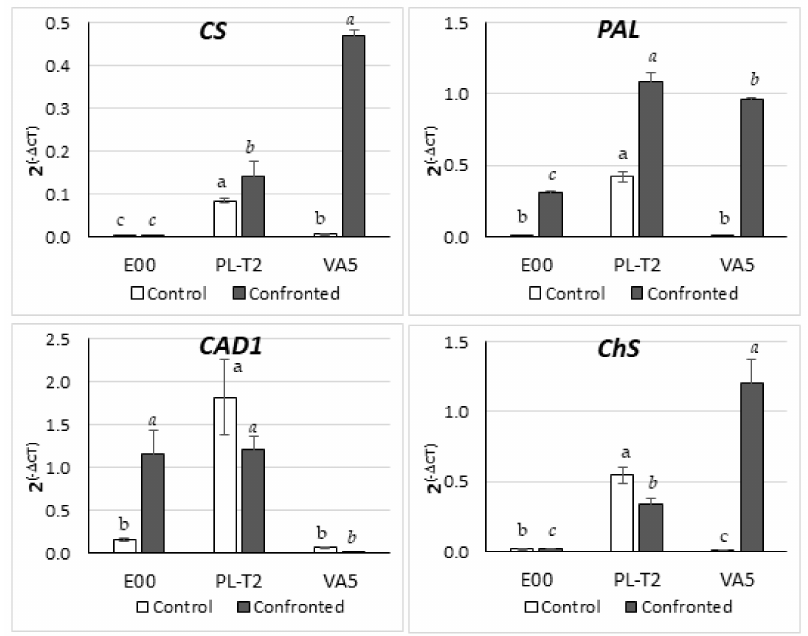
Figure 8. Expression of chorismate synthase ( CS ), phenylalanineammonia-lyase ( PAL ), NADPH- dependent cinnamyl alcohol dehydrogenase ( CAD 1), and chalcone synthase ( ChS ) genes in in vitro shoots Q. ilex of genotypes E00, PL-T2, and VA5. Data are mean ± SD of amplifications performed in triplicates. Within each gene and treatment, values with the same letter did not differ significantly according to ANOVA